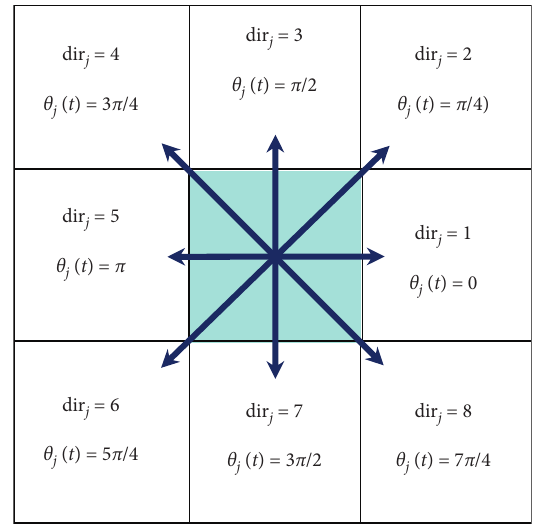
Figure 4: Corresponding relationship between forward direction and included angle radian.